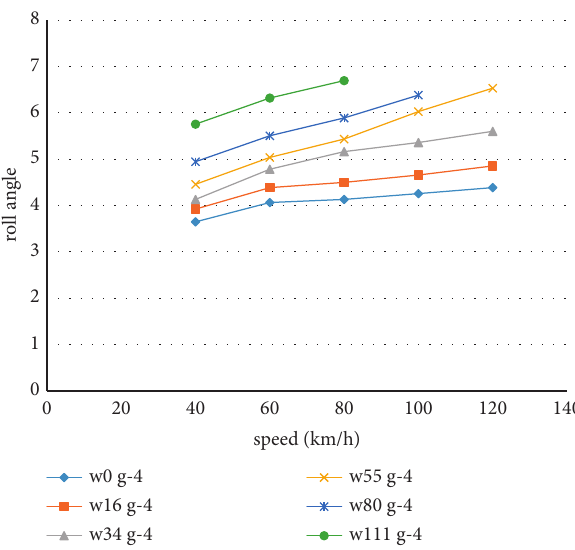
Figure 18: Comparison of maximum overturning angle values at different wind speeds.